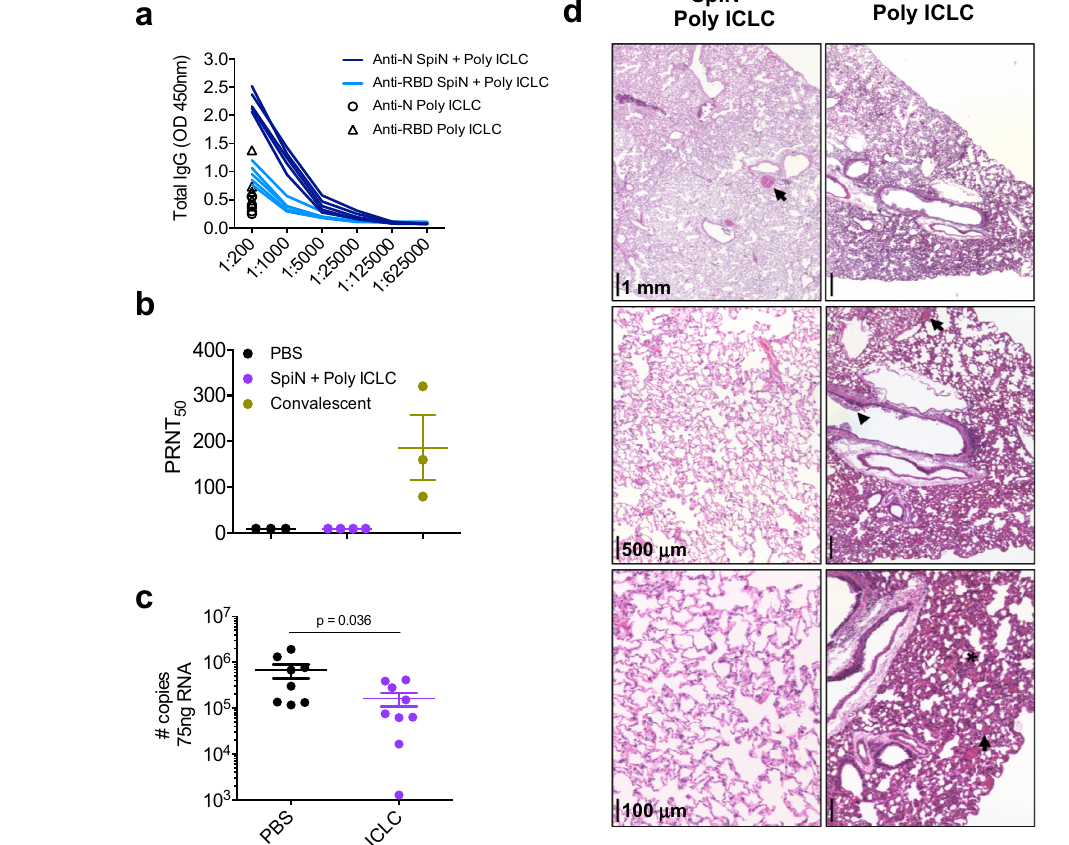
(asterisk),associatedwithaccentuateddiffusecongestion(blackarrow)andmixed in fl ammatory in fi ltrate (mononuclear and polymorphonuclear cells). In the bron- chial space, in fl ammatory cells are noted with a predominance of neutrophils associated with cellular debris (arrowhead) ( d , right panels ). In comparison, hamsters immunized with SpiN adjuvanted with Poly ICLC had mild focal conges- tion (black arrow) with alveolar space preservation ( d , left panels ). a – d Data are representative of two independent experiments. a n =5 hamsters/group. d PBS n =3, SpiN + Poly ICLC n =4, Convalescent n =3. c Pooled data from two inde- pendentexperiments, n =7 – 8hamsters/group.Dataofviralloadquanti fi cationwas analyzed through two-sided Mann – Whitney